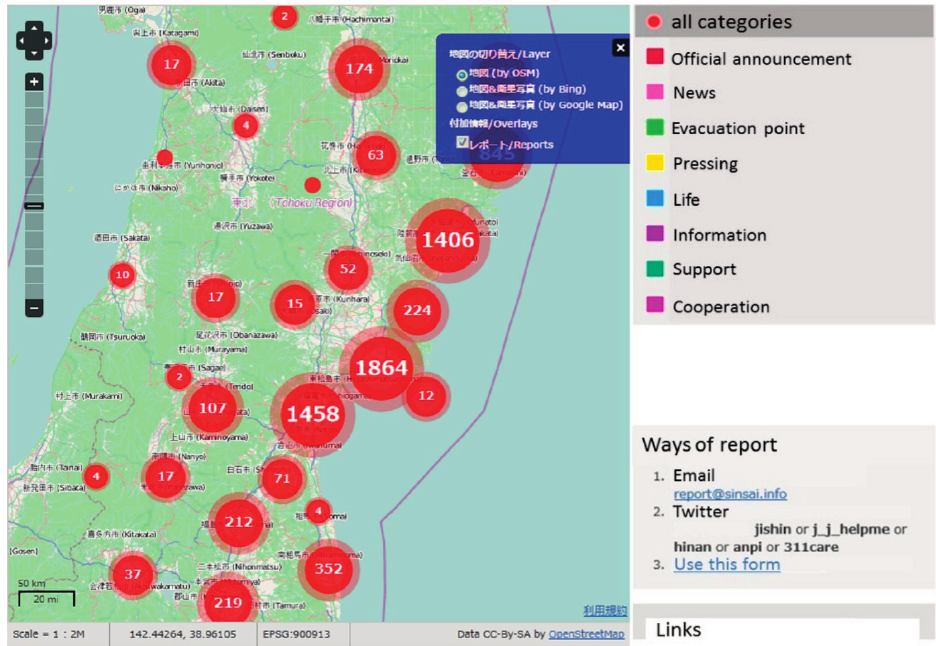
Figure 2. One example of a system based on